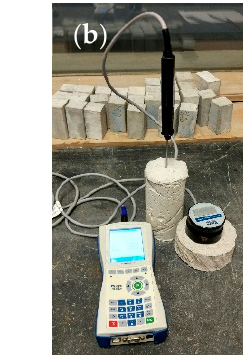
Figure 1. Aerogel-based render’s visual aspect during the mixing process ( a ) and the specimens (cylindric I with a linear probe; closer—cylindric II with a plane probe) and ISOMET 2114 equipment from Applied Precision supplier ( b